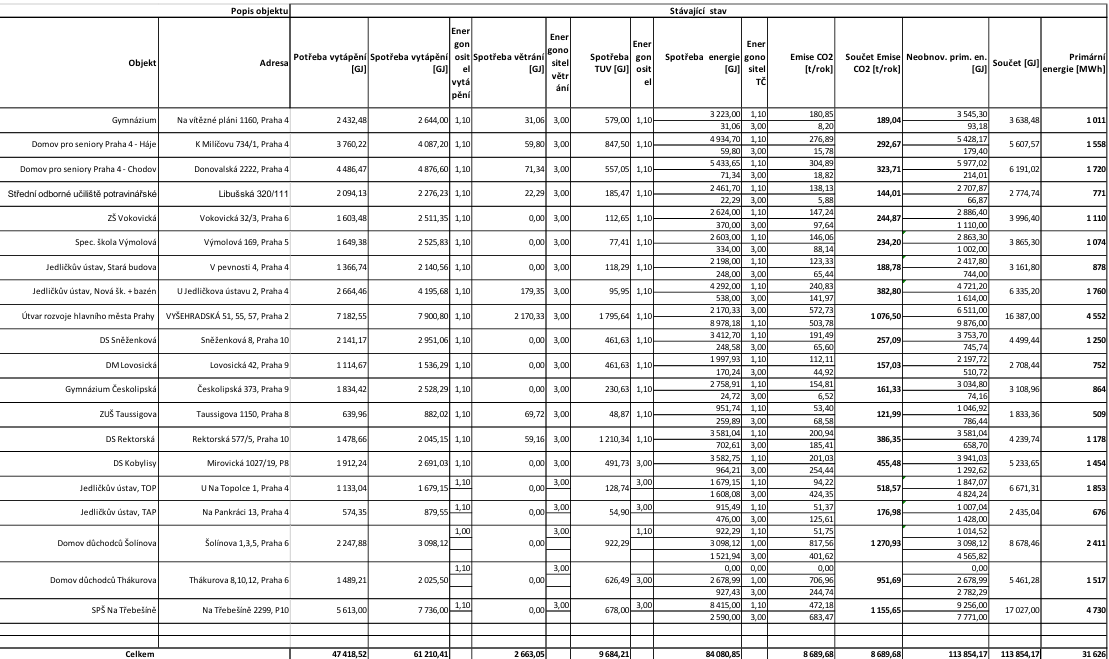
Tab 6: Současné energetické náročnosti objektů vybraných do pilotního